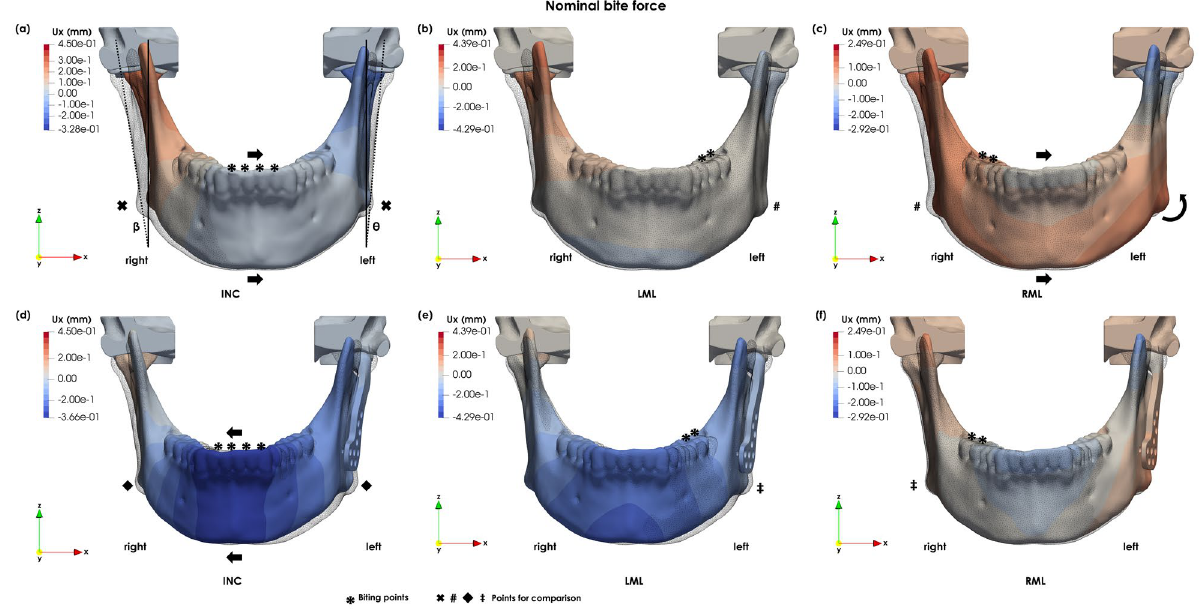
Figure 3. Medio-lateral displacements of the intact mandible for ( a ) INC, ( b ) LML al and ( c ) RML, and for the implanted mandible ( d ) INC, ( e ) LML and ( f ) RML (scaling factor × 20).